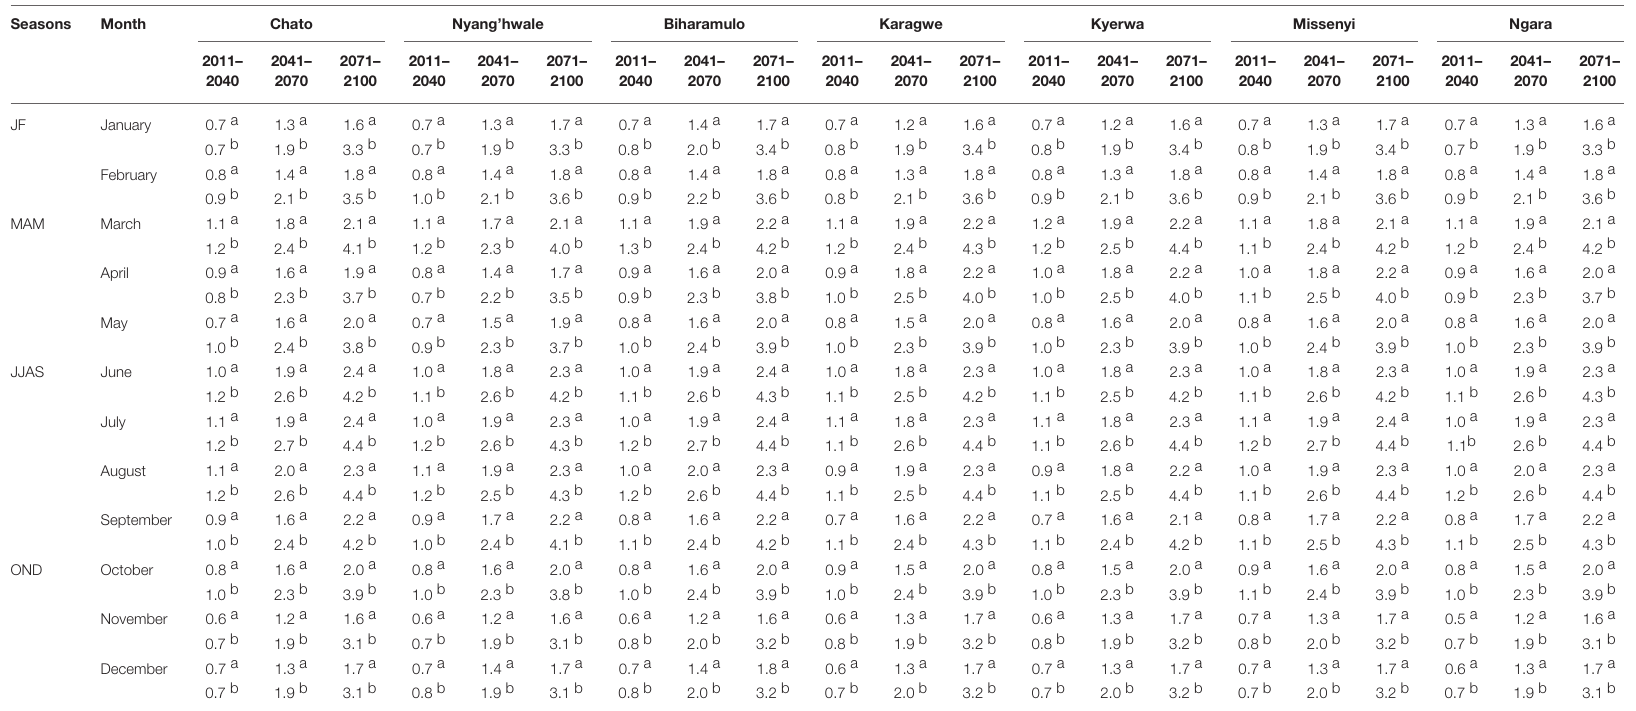
TABLE 7 | Projected change in maximum temperature ( ◦ C) in the Kagera and Geita regions during the present (2011–2040), mid (2041–2070), and end (2071–2100) century for Representative Concentration Pathway a (RCP) 4.5 scenario and b RCP 8.5 scenario. Seasons Month Chato Nyang’hwale Biharamulo